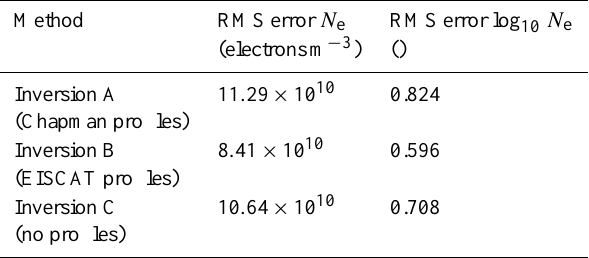
Table 1. RMS errors with respect to EISCAT incoherent